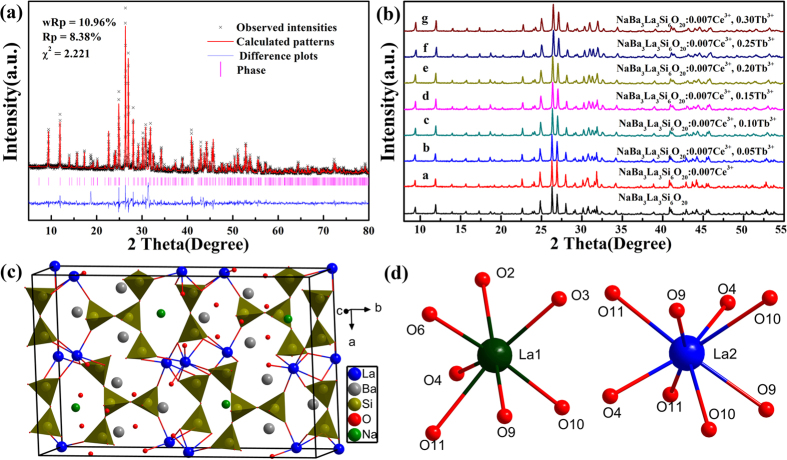
(a) The XRD profiles for the Rietveld refinement of NaBa3La3Si6O20. (b) The XRD patterns of the NaBa3La3Si6O20, NaBa3La3Si6O20:0.007Ce3+ and NaBa3La3Si6O20:0.007Ce3+, yTb3+ phosphors. (c) The structure of unit cell of NaBa3La3Si6O20 along the c axis. (d) The coordination environments of La1 and La2 in NaBa3La3Si6O20.